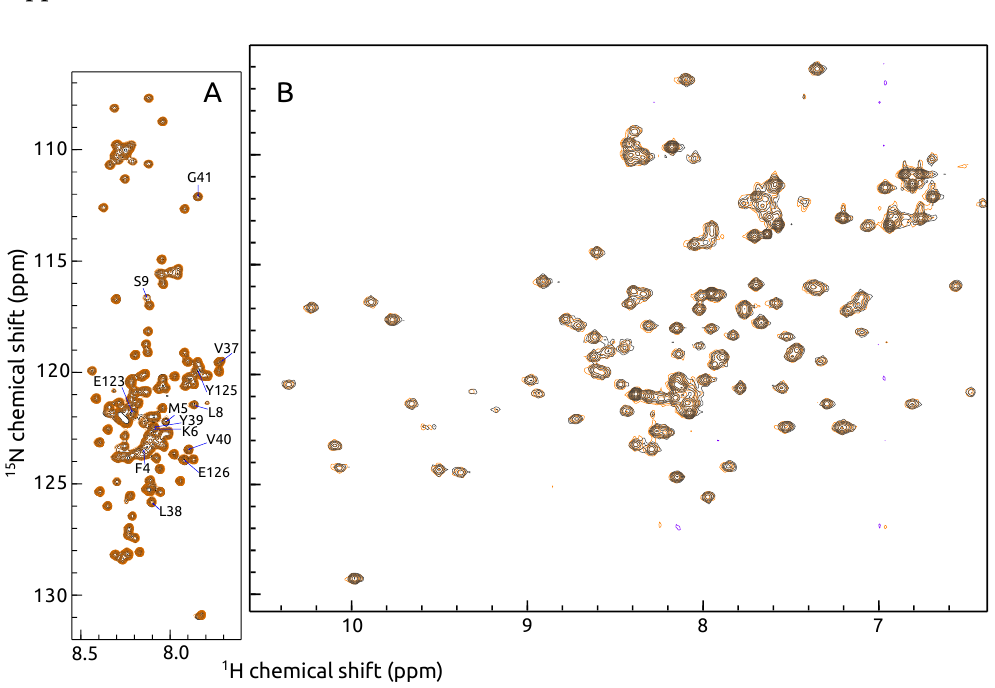
Figure A1. The overlay 15 N– 1 H HSQC spectra of ( A ) 15 N α -syn (black) and 15 N α -syn in the presence of S100A9 (orange), ( B ) 15 N S100A9 without (black) and with (orange) α -syn.